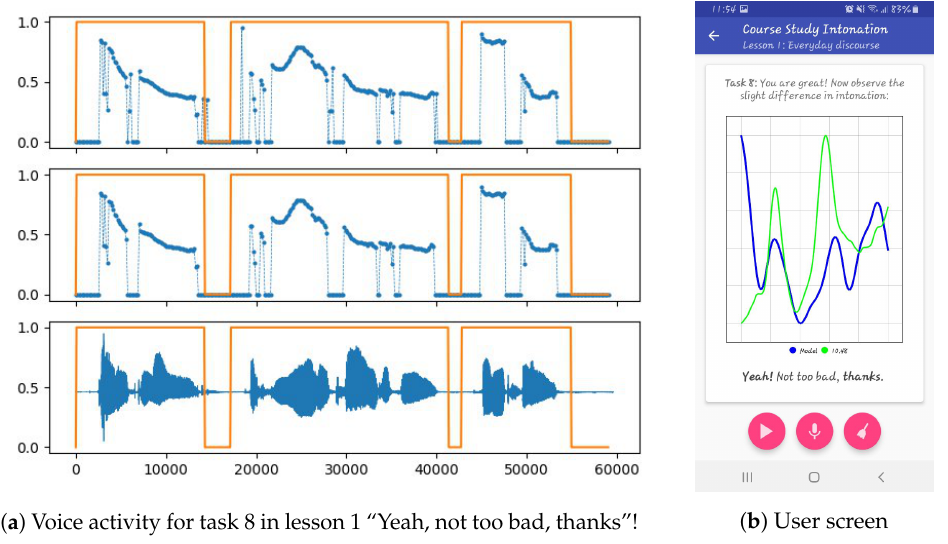
Figure 1. Voice activity detection process and pitch curves displayed by the mobile